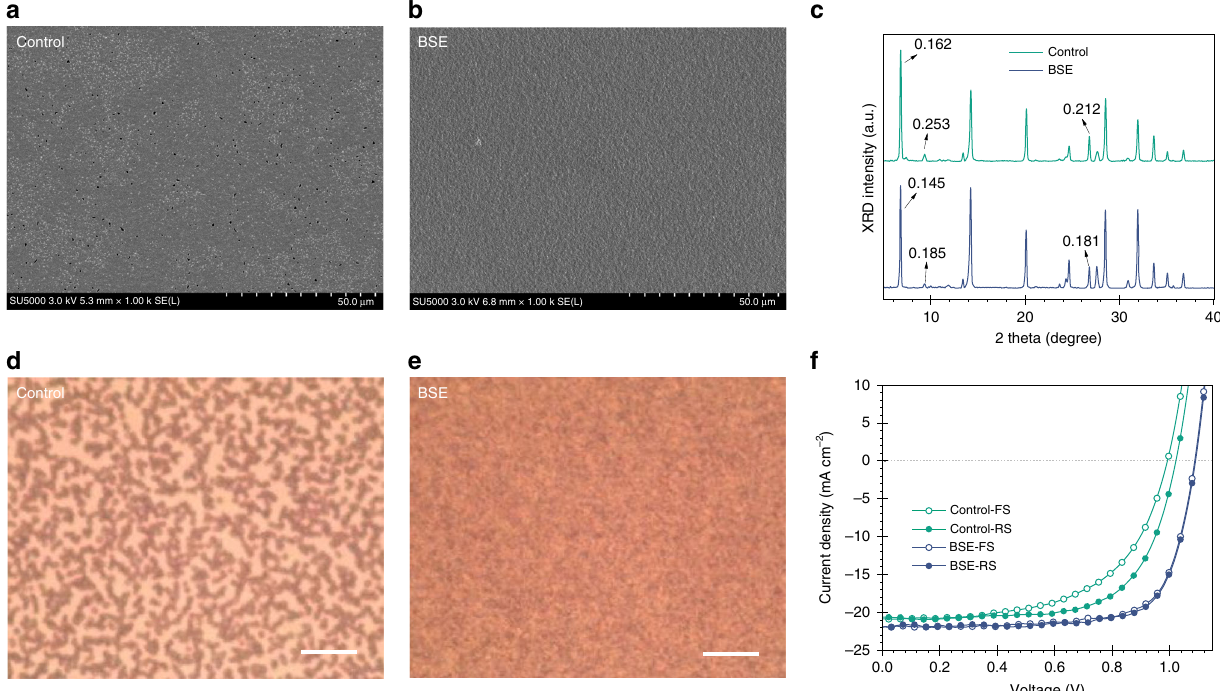
Fig. 2 Morphology and photovoltaic performance of perovskite fi lms prepared by boosted solvent extraction (BSE) and non-BSE methods. a , b SEM images of perovskite fi lms prepared using non-BSE and BSE methods; all images are acquired following thermal annealing. d , e Optical microscope images showing perovskite fi lms prepared by non-BSE and BSE methods before thermal annealing. Scale bar: 10 µ m. c X-ray diffraction pattern of perovskite fi lms prepared by non-BSE and BSE methods before thermal annealing. Numbers are full width at half maximum. f JV curves of devices based on the BSE and non-BSE perovskite fi